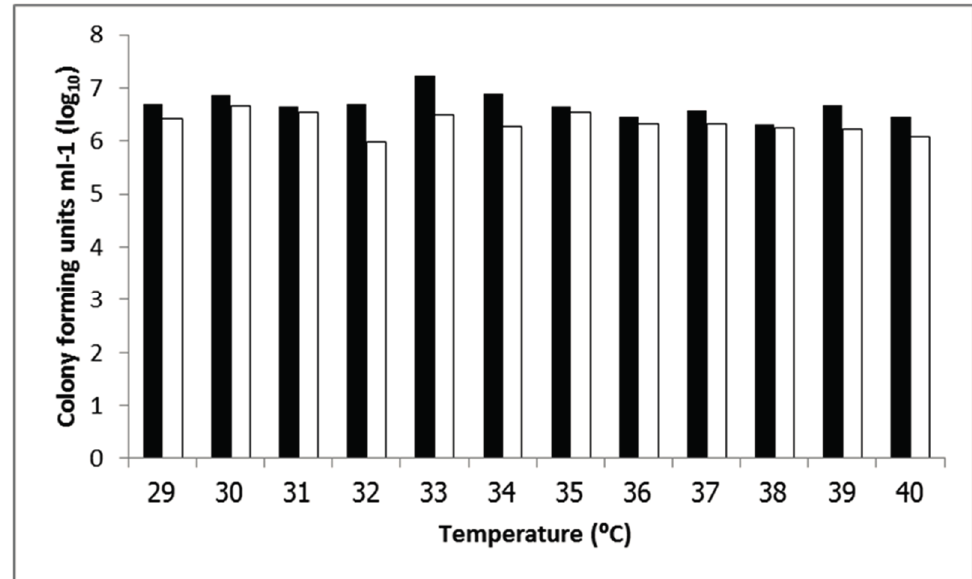
Figure 2. Number of colony forming units mL − 1 from EAEC strain 17-2 ( ■ ); and strain 042 ( □ ) in an Adherence assay.